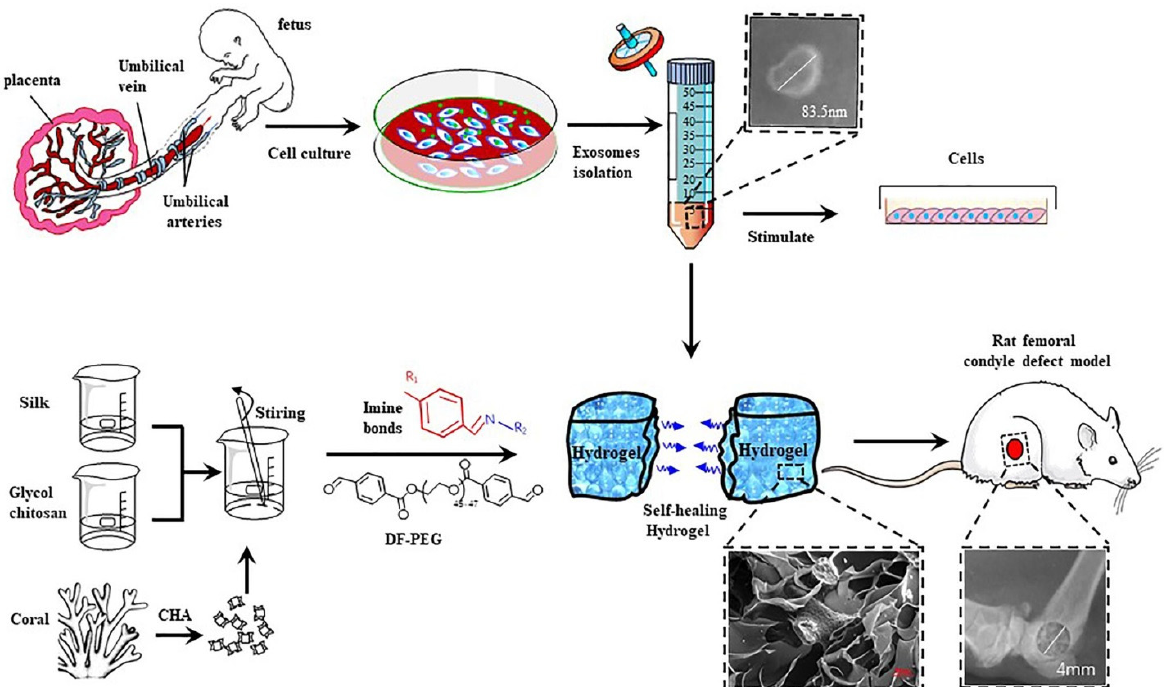
Figure 15. Schematic representation of the hucMSC-derived exosomes isolation and synthesis of CHA/SF/GCS/DF-PEG hydrogel for bone defect treatment in rat bone defect model. (Reproduced with permission from Ref. [210]) under Creative Commons Attribution License (CC BY)).